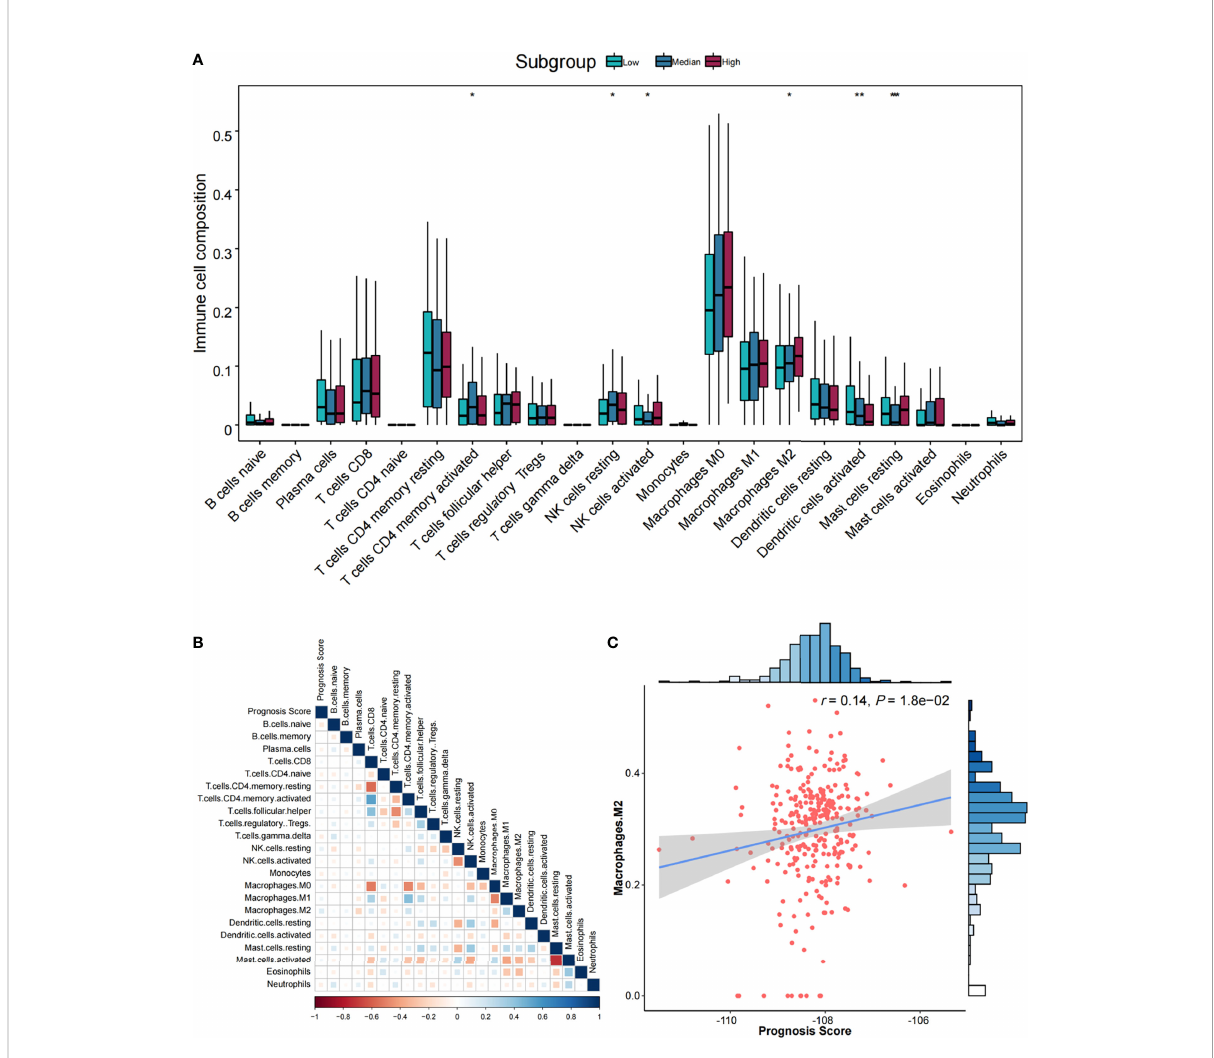
FIGURE 5 The association analysis between immune cells and prognostic score. (A) Comparisons of the abundances of 22 immune cells in three risk groups. * p < 0.05, ** p < 0.01, and *** p < 0.001. (B) Heatmap of correlations among immune cells and prognostic score. Correlation coef fi cients were derived from Pearson correlation analysis. (C) Scatter plot and association analysis between prognostic score and M2